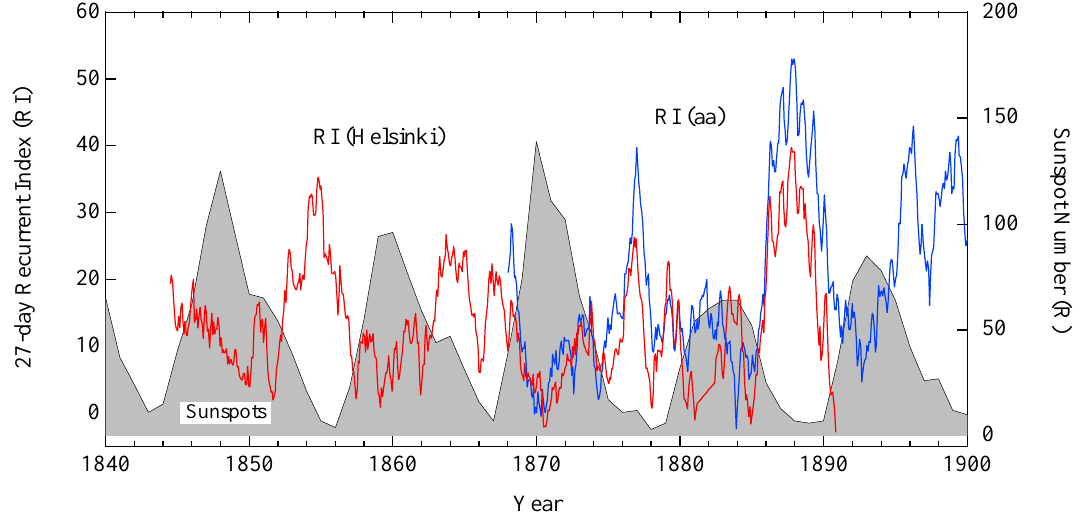
Fig. 5. Sargent’s recurrent activity index (RI) calculated from daily values of Helsinki data (Ak(H)) and Mayaud’s aa . Sunspot numbers are shown at the